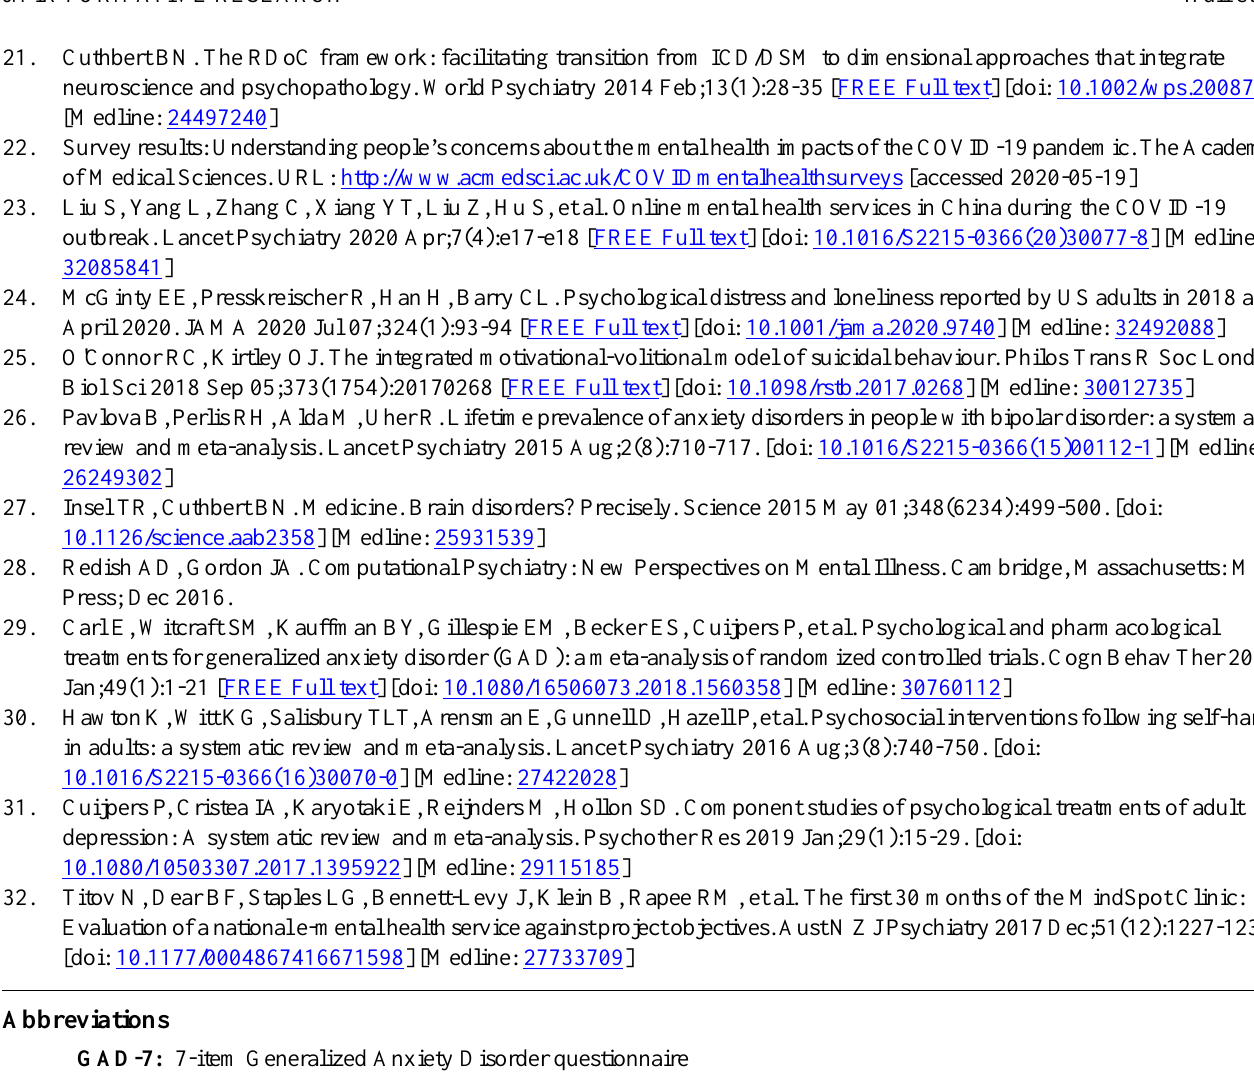
GAD-7: 7-item Generalized Anxiety Disorder